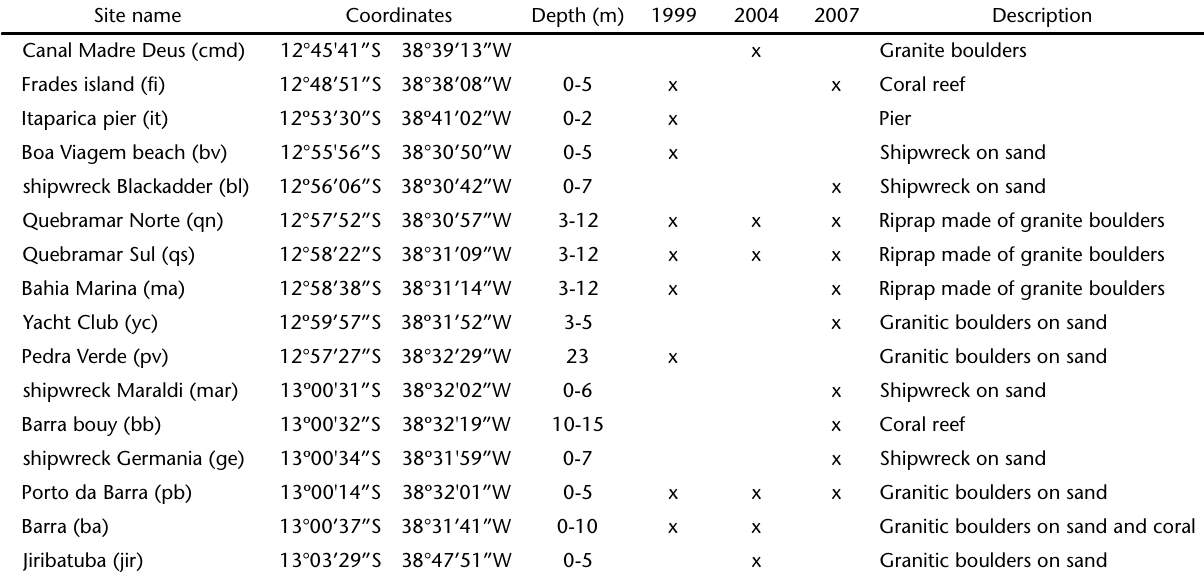
Table I. Sites visited during rapid assessments for ascidians in Todos os Santos Bay regions, state of Bahia,